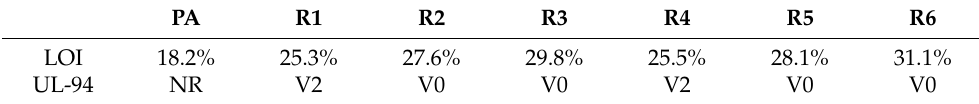
Table 2. LOI and UL–94